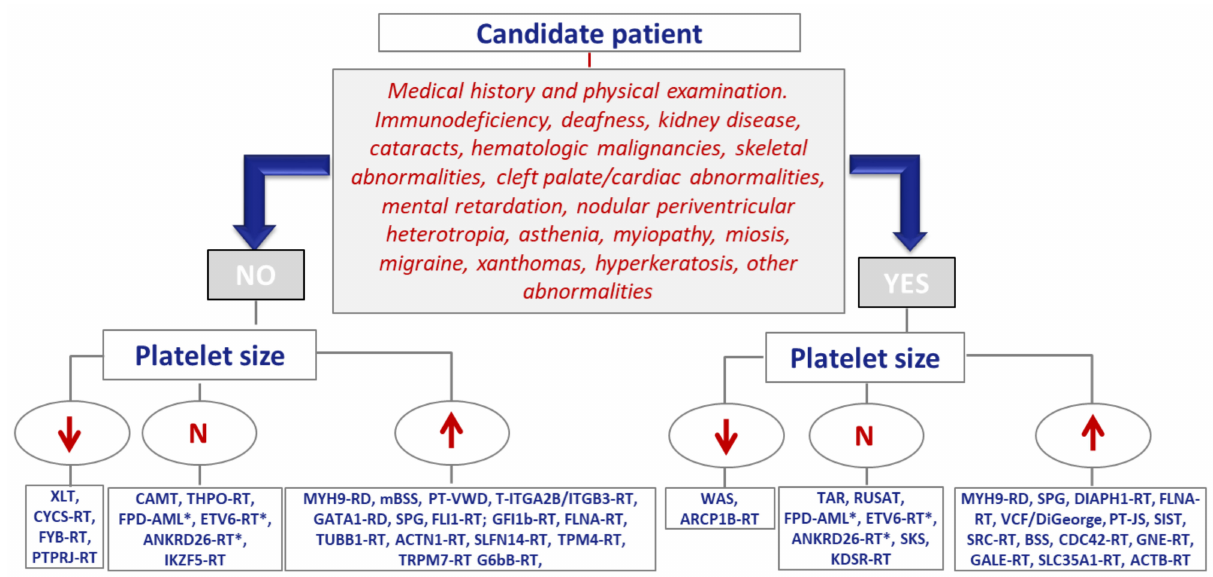
Figure 2. Diagnostic approach for inherited thrombocytopenias. N: Normal; XLT: X-Linked thrombocytopenia; CYCS- RT: CYCS-related thrombocytopenia (thrombocytopenia type 4); FYB-RT: FYB-related thrombocytopenia (adap-related thrombocytopenia); PTPRJ-RT: Thrombocytopenia due to variants affecting the phosphatase CD148; CAMT: Congenital amegakaryocytic thrombocytopenia (associated to a severe bone marrow aplasia ); THPO-RT: thrombocytopenia due to mutations in THPO encoding thrombopoietin; FPD-AML: Familial platelet disorder with propensity to acute myel- ogenous leukemia; ANKRD26-RT: Thrombocytopenia due to variants affecting ankyrin repeat domain 26; ETV6-RT: Thrombocytopenia due to variants in the transcription factor ETV6; IKZF5-RT: Thrombocytopenia due to variants in the transcription factor IKZF5; MYH9-RD: Disorders related to variants in MYH9 (neutrophil inclusions, deafness, kidney disease, cataracts); mSBS: monoalellic Bernard-Soulier syndrome (Mediterranean macrothrombocytopenia); PT-VWD: Platelet type von Willebrand disease; ITGA2B/ITGB3-RT: Thrombocytopenia due to variants in ITGA2B/ITGB3 ; GATA1- RD:GATA1–related disorders (commonly associated to red cells anomalies); GPS: Gray platelet syndrome (myelofibrosis); FLI1-RT: Thrombocytopenia due to variants in the transcription factor FLI1; GFI1-RT: Thrombocytopenia due to variants in GFI1B (abnormal CD34 expression in platelets); FLNA-RT: Thrombocytopenia with filaminopathy (syndromic or only thrombocytopenia); TUBB1-RT; Thrombocytopenia due to variants affecting tubulin b1; ACTN1-RT: Thrombocytopenia due to variants affecting Actinin-1; SLFN14-RT: SLFN14-Related thrombocytopenia; TPM4-RT: Thrombocytopenia due to variants in tropomyosin 4; TRPM7-RT: Thrombocytopenia related with the ionic channel TRPM7; G6b-B: Thrombocytopenia due to variants affecting the immunoreceptor G6b-B (myelofibrosis); WAS: Wiskott-Aldrich syndrome (eczema and severe infections; ARCP1B-RT: Mycrothrombocytopenia linked to a ARCPB; TAR: Thrombocytopenia with absent radii; RUSAT: Radioulnar synostosis with amegakaryocytic thrombocytopenia; SKS: Stormorken syndrome; KDSR-RT: Thrombocytopenia with variable hyperkeratosis due to variants affecting 3-dehydrosphinganine reductase; DIAPH1-RT: Thrombocytopenia associated to dominant deafness and variants in DIAPH1; PT-JS: Paris-Trousseau/Jacobsen syndrome; VCF-DiGeorge syndromes: velocardiofacial/DiGeorge syndrome; SIST: sistosterolemia (elevated plasma levels of plant sterols); SRC: Thrombocytopenia associated to gain-of-function variant in tyrosine kinase SRC; BSS: Bernard-Soulier syndrome; CDC42-RT: CDC42-related thrombocytopenia (Takenouchi-Kosaki syndrome); GNE-RT: GNE-related thrombocytopenia; GALE-RT: GALE-related thrombocytopenia (galactosemia); SLC35A1-RT: Syndromic thrombocytopenia due to variants affecting the CMP-sialic acid transporter; ACTB-RT: Thrombocytopenia due to variants affecting actin beta; * Disorders with high risk of hematological